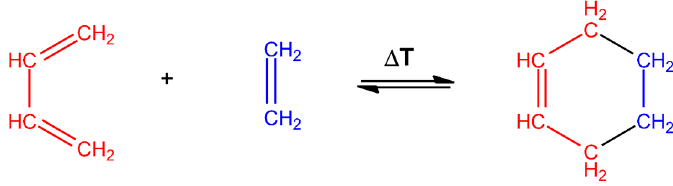
Figure 3. Diels-Alder reaction between a diene and a dienophile.